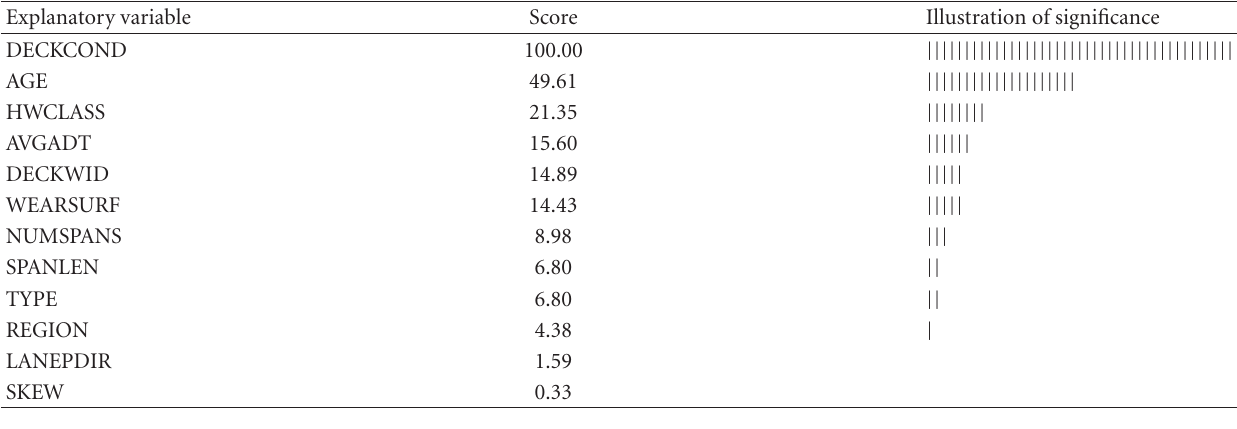
Table 4: Significance level of explanatory variables used for bridge deck condition prediction.